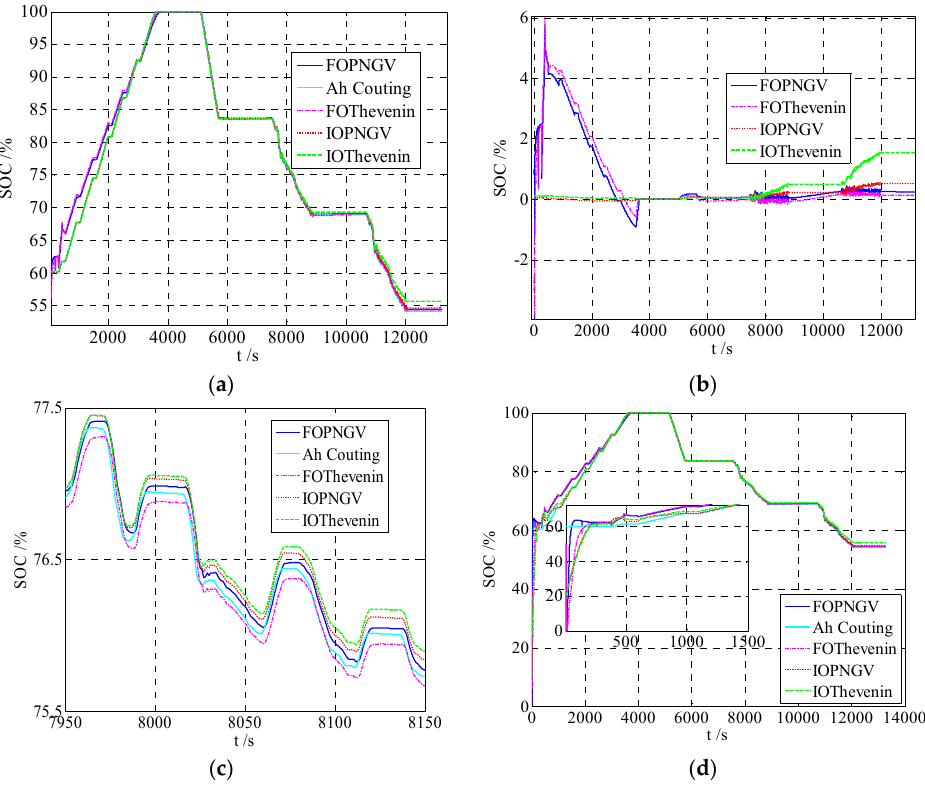
Figure 9. EKF for SOC estimation of the lithium-ion battery: ( a ) estimation under hybrid driving cycles; ( b ) estimation error of ( a ); ( c ) estimation under UDDS driving cycles; ( d ) convergence of EKF.